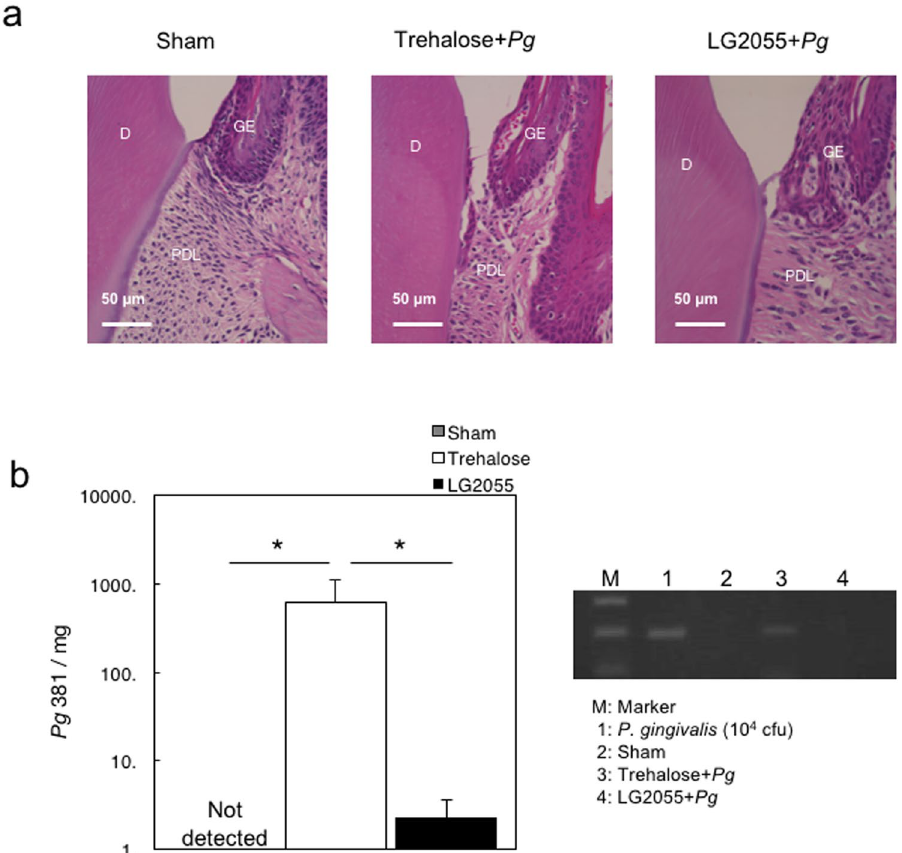
Figure 2. Suppression of P . gingivalis -induced detachment and disorganization of the periodontal ligament, and bacteria detection by gastric intubation with LG2055. ( a ) Histochemical analysis of gingival tissue. Thirty days after P . gingivalis infection, mouse lower jaws with gingival tissue were stained with hematoxylin and eosin. D: dentin, GE: gingival epithelium, PDL: periodontal ligament. ( b ) Detection of P . gingivalis -specific 16 S rRNA. Thirty days after P . gingivalis infection, DNA was extracted from gingival tissues of mice and amplified using real-time quantitative PCR with a pair of primers corresponding to P . gingivalis -specific 16 S rRNA. Different numbers of DNA from P . gingivalis 381 were used to generate a standard curve. All values are expressed as the means ± SEM per mg of tissue for eight mice per group; * p <